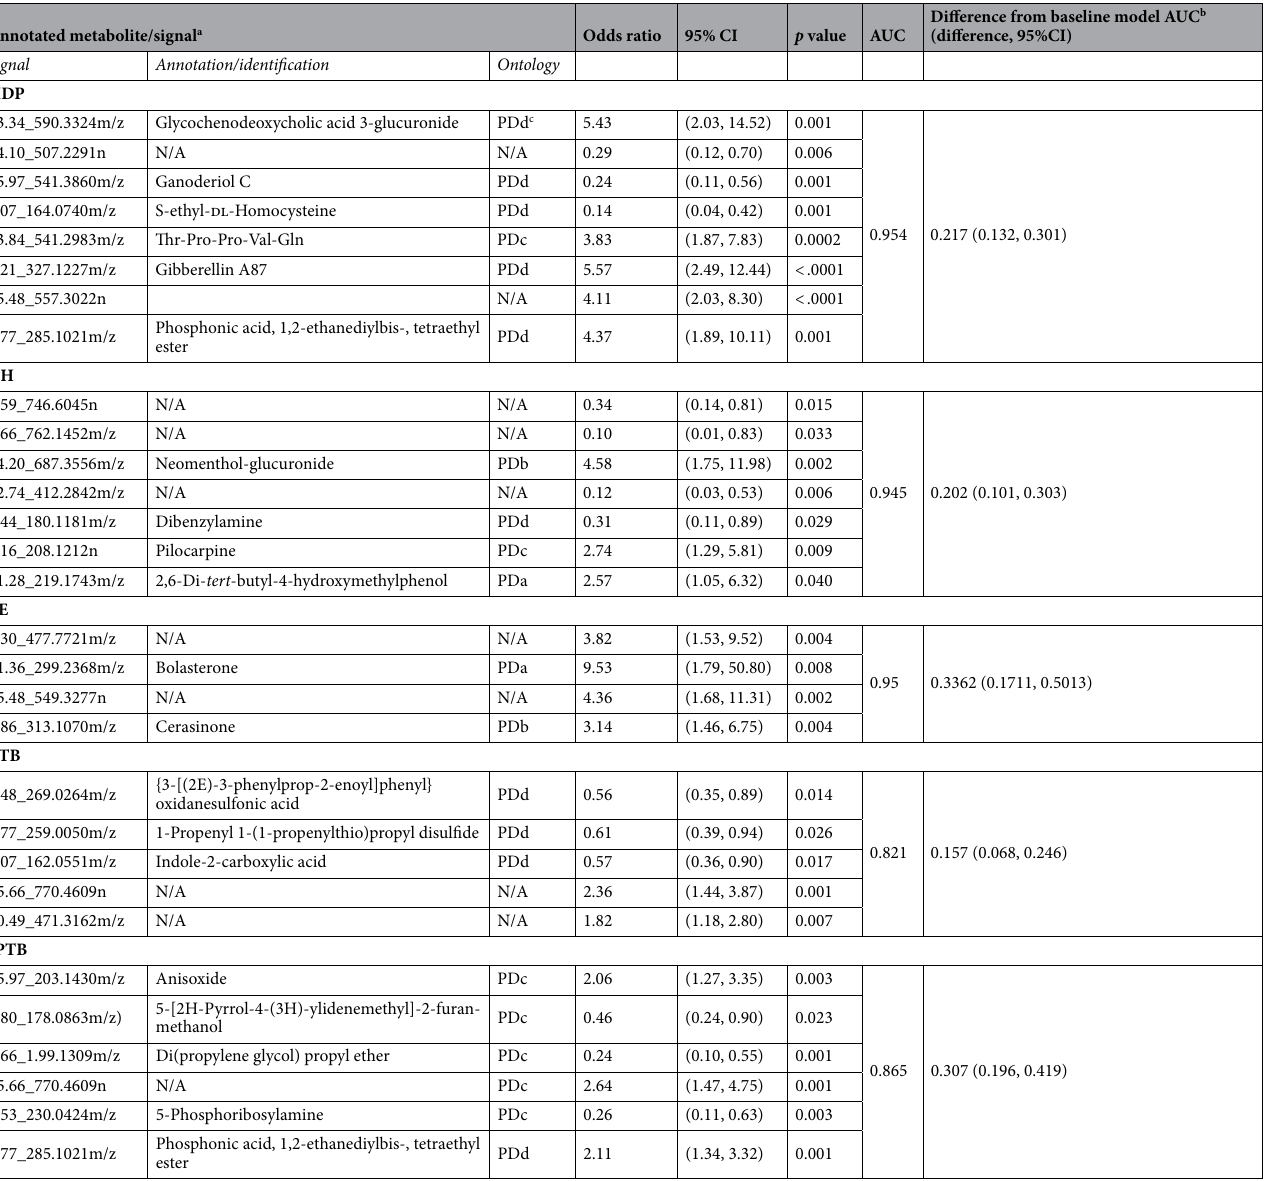
Table 2. Metabolites/signals that predicted HDP, GH, PE, PTB, and sPTB in multiple logistic regression models (LC–MS). HDP, any hypertensive disorder of pregnancy; GH, gestational hypertension; PE,